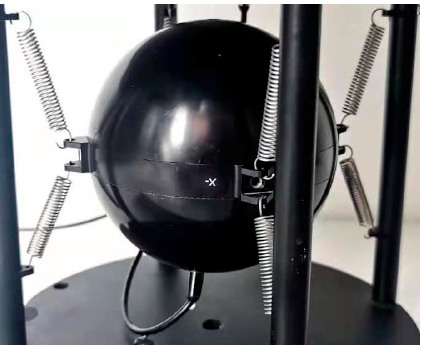
Figure 3. The structural image of the OSSS assembly.